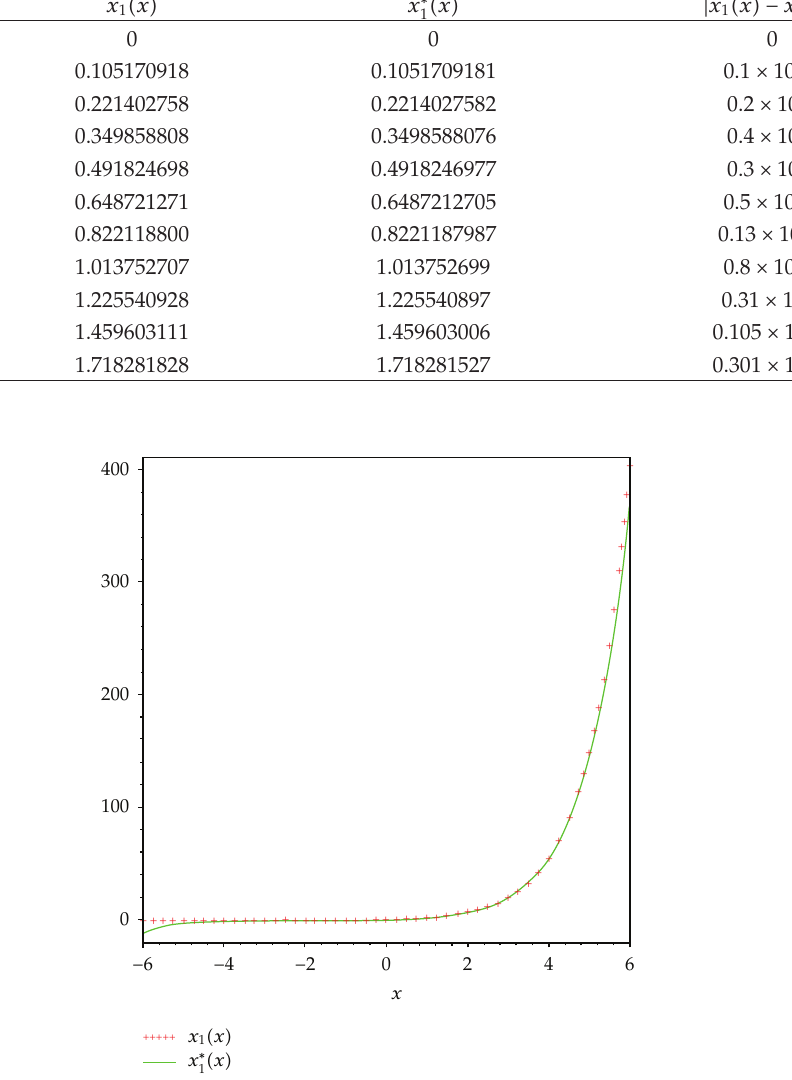
(cid:3) x (cid:4) variational 1